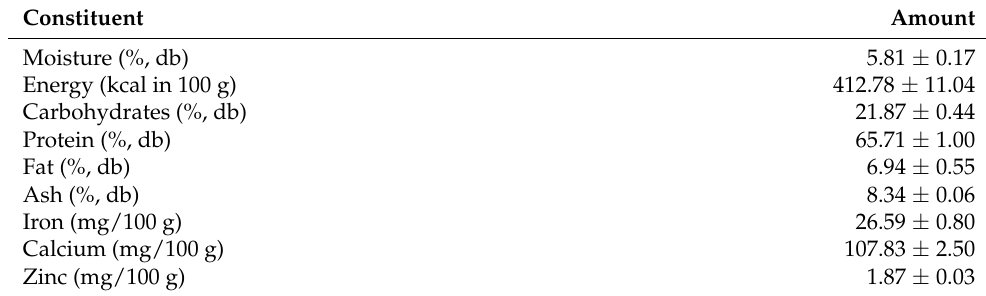
Table 1. Proximal composition of biomass of Spirulina sp. CCC 540 (means ±